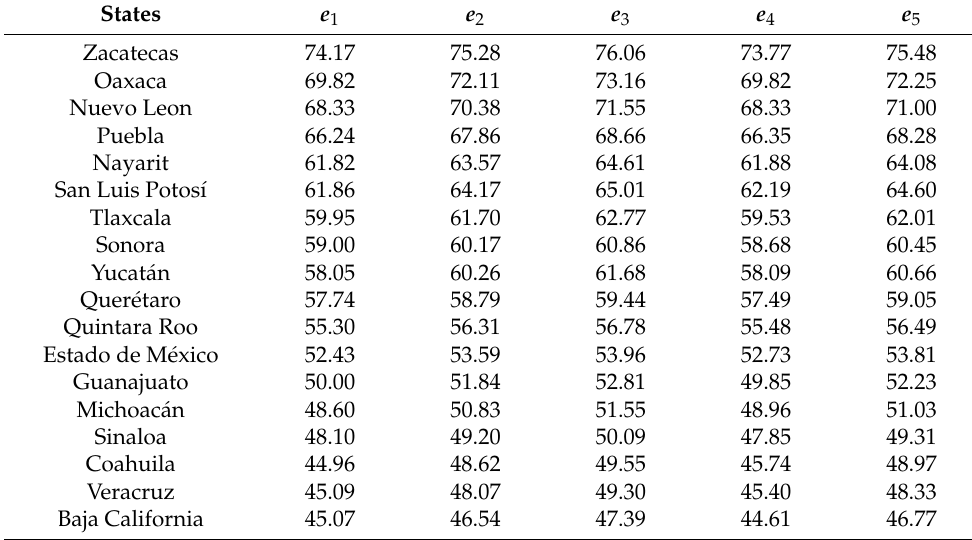
Table A4. Bon-HOWA operator